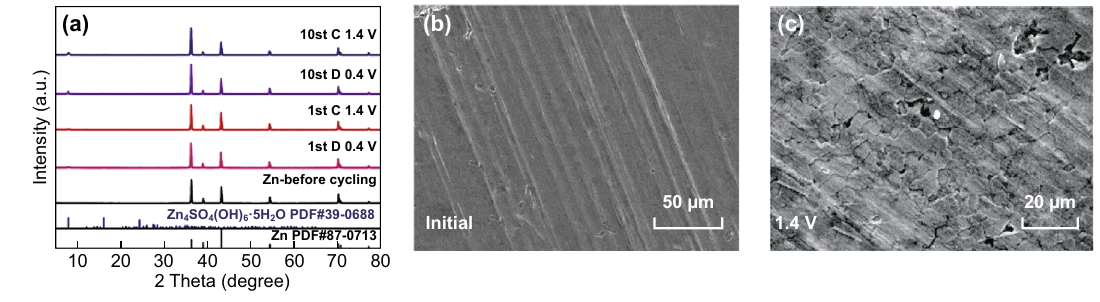
Fig. 6 a XRD patterns of Zn anodes from Zn/V 4+ -V 2 O 5 batteries at different states. SEM images of Zn anodes from Zn/V 4+ -V 2 O 5 batteries at different states: b initial and c charged to 1.4